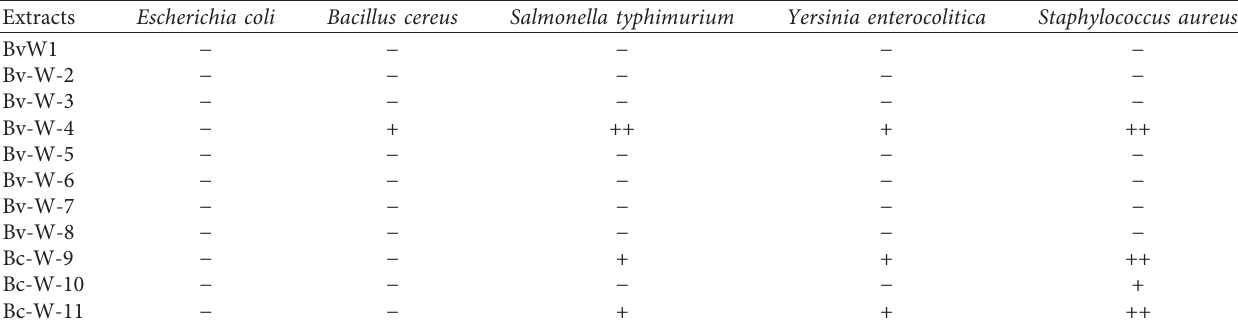
Table 5: Antimicrobial activities of Berberis fruit extracts against foodborne pathogens.